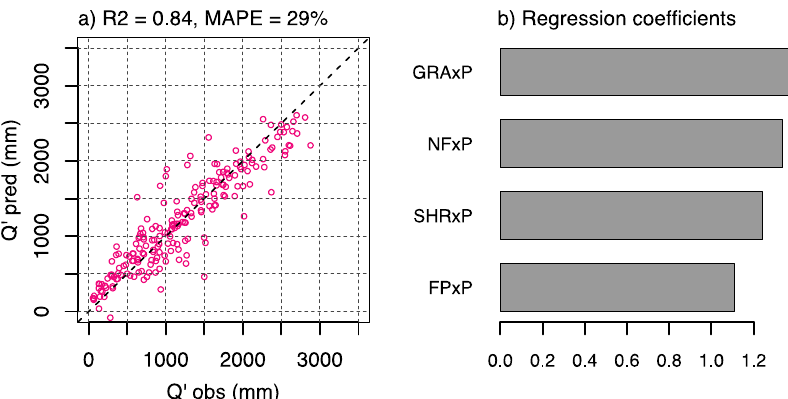
Figure 8. Modelling results. Panel ( a ) presents the scatter plot between the predicted and observed annual runoff (the R 2 and MAPE are indicated). Panel ( b) shows the calibrated regression coefficients for each predictor.